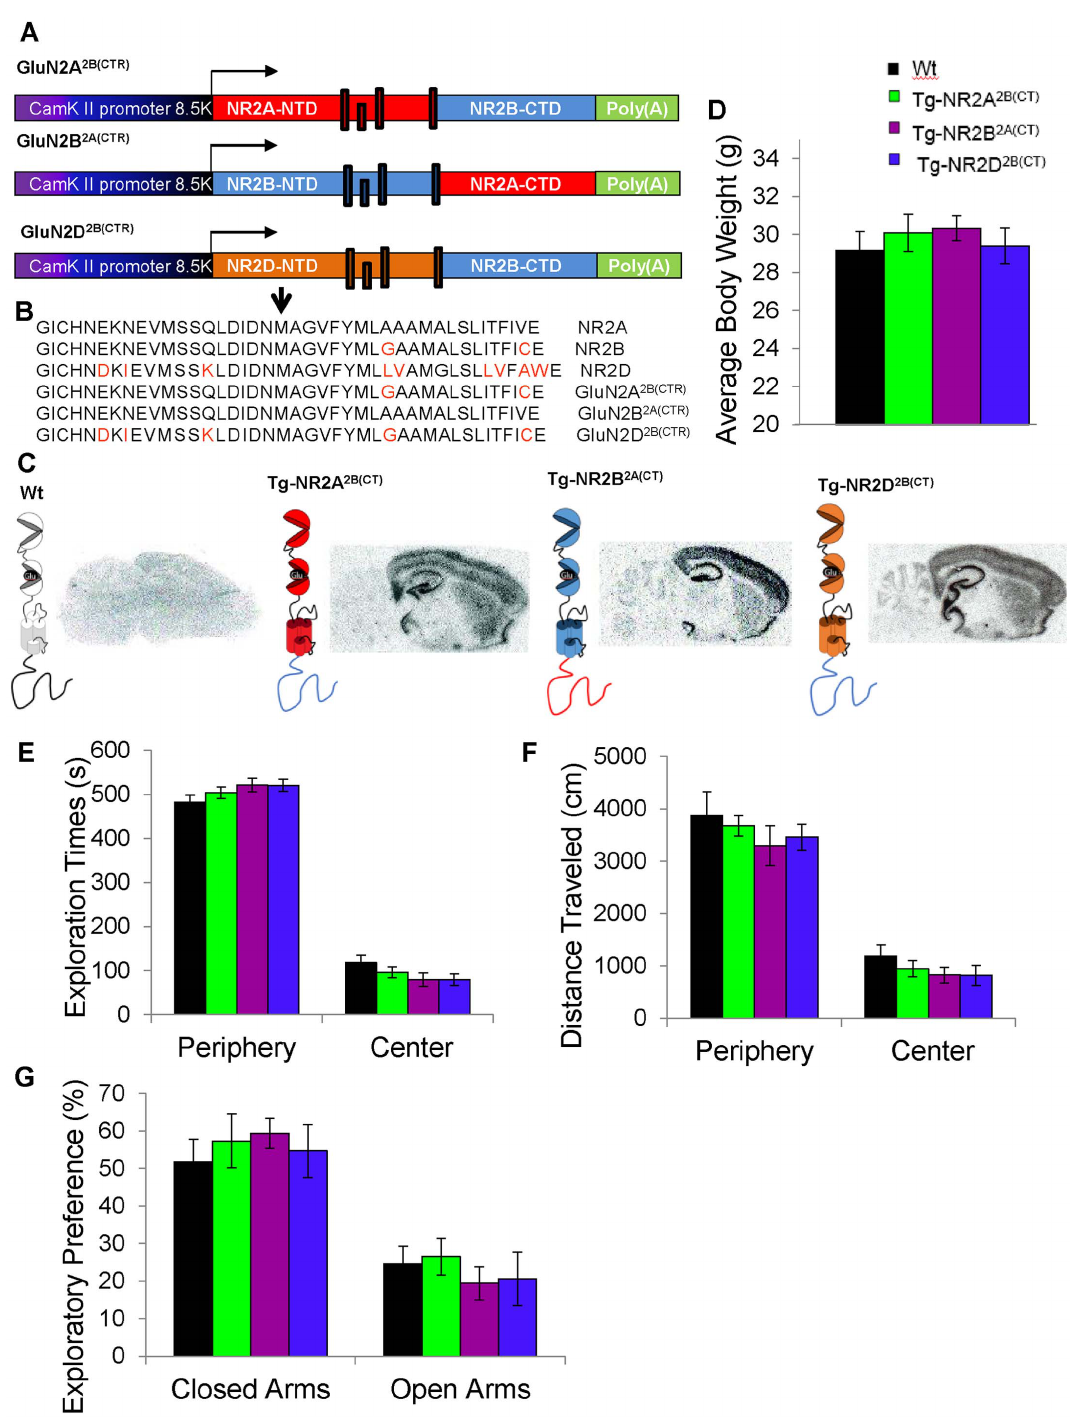
Figure 1. Constructs and basic behavioral assays of the GluN2 chimeric mice. ( A ) Illustration of the constructs used to create the GluN2A 2B(CTR) , GluN2B 2A(CTR) , and GluN2D 2B(CTR) chimeric subunits. ( B ) A point mutation was made on the cloning vector to induce an Aat II cutting sites to link the N-terminal and membrane domain to the C-terminal domain. After successfully joining the domains, the point mutation was restored to the original sequence. The arrow indicates the fusion position located in trans-membrane domain. ( C ) In situ hybridization of the transgene expression in the wild-type mice (Wt), the Tg-GluN2A 2B(CT) mice, the Tg-GluN2B 2A(CT) mice and the Tg-GluN2D 2B(CT) mice using SV-40 probes with a schematic of the receptor subunit expressed in the excitatory neurons. ( D ) No differences were found in the average adult body weight of the wild- type mice, the Tg-GluN2A 2B(CT) , Tg-GluN2B 2A(CT) , and Tg-GluN2D 2B(CT) mice. ( E ) The chimeric transgenic mice spent similar amounts of time as the wild-type mice in the center verses the periphery of the open field arena. ( F ) The chimeric transgenic mice and the wild-type mice showed similar locomotion in the open field. ( G ) The Tg-GluN2A 2B(CT) , Tg-GluN2B 2A(CT) and Tg-GluN2D 2B(CT) mice spent similar amounts of time in the closed arms and the open arms of the elevated plus maze as the wild-type mice.